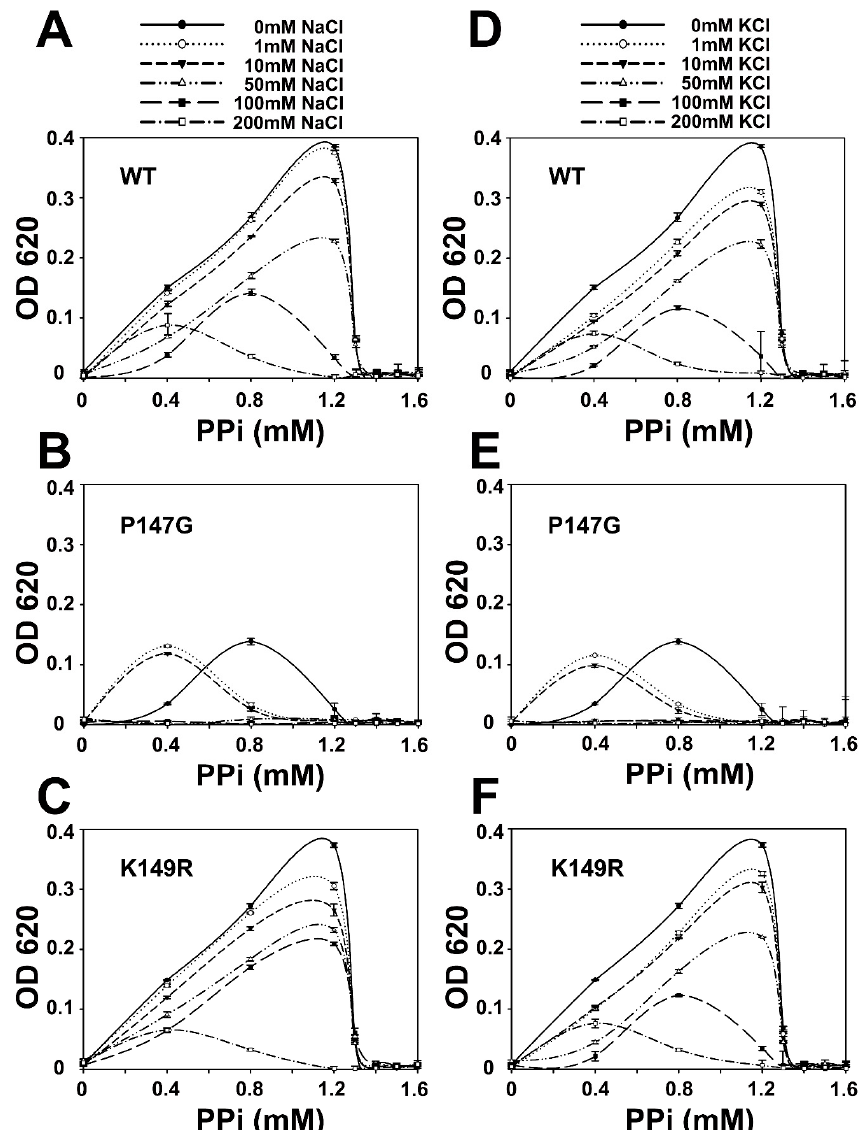
Figure 7. The enzyme assay inhibitory effects of Na+ and K+ on WT, P147G, and K149R of AbPPase. ( A , D ) Na + and K + could, in a concentration-dependent manner, inhibit WT of AbPPase hydrolysis of PPi, respectively. The higher the Na + and K + concentration, the lower the WT of AbPPase catalysis activity. ( B , E ) Na + and K + inhibit P147G of AbPPase hydrolysis of PPi, respectively. ( C , F ) Na + and K + could, in a concentration-dependent manner, inhibit K149R of AbPPase hydrolysis of PPi, respectively. K149R variant showed a similar behavior to the WT AbPPase to the inhibition of monovalent cations. Error bars represent standard deviation for n = 3 independent experiments. It has been reported that there is an equilibrium between trimeric and hexameric forms of PPase. The trimeric form of PPase exhibited different catalytic activity compared to the WT enzyme [41,42]. Gel filtration demonstrated that Na + , Mg 2+ , and PPi do not greatly alter the global fold of AbPPase (Figure 8 A,B). The elution profiles of AbPPase in these running buffers are the same, indicating that the inhibitory effects of Na + occur via binding to the loop, rather than by altering the global structure of the enzyme.